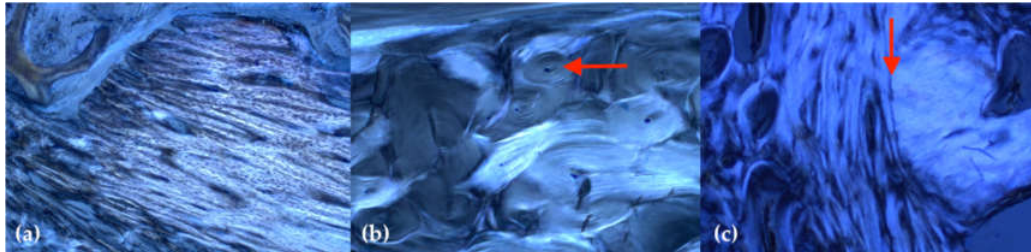
Figure 4. Representative imaging of the bone structure in polarized light (staining: toluidine blue; magnification: 50×): (a) primarily parallel aligned, newly formed bone structure in the former tooth socket; (b) the remaining cortical bone shows a typical osteon structure (red arrow); (c) border (red arrow) between the original bone tissue (right) and new bone tissue resulting from remodelling (left). Almost no BSM granules encapsulated with bone tissue could be detected in the extraction